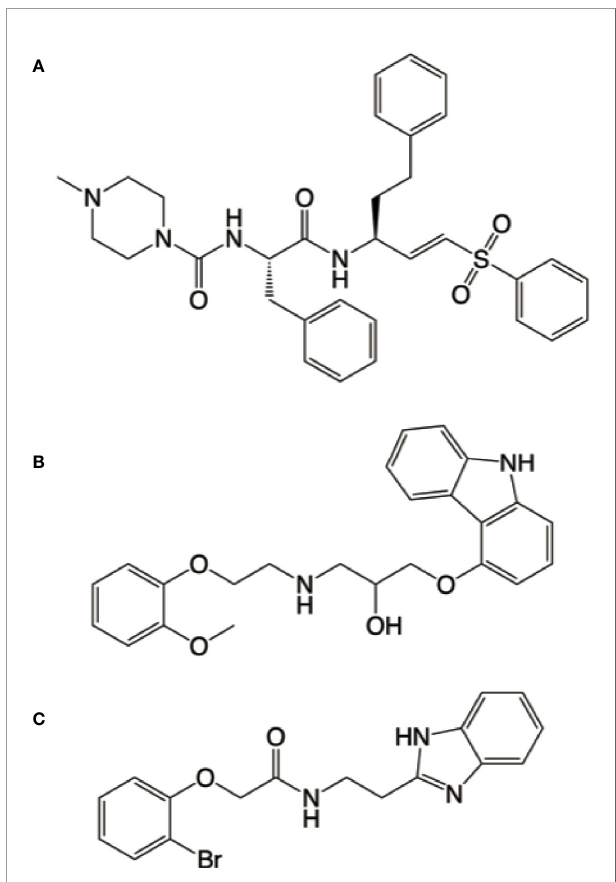
FIGURE 1 | Cruzipain competitive ligands. Chemical structures of K777 (A) , carvedilol (B) and B95 (C) generated by using Chemdraw V19.0 (Perkin Elmer Informatics). Cruzipain bound to K777 (PDB entry 2OZ2) was used as a model for our virtual screening, where carvedilol (B) was identi fi ed as a hit. It is evident the resemblance between carvedilol and B95, which has been crystallized bound to the active site of cruzipain (PDB entry